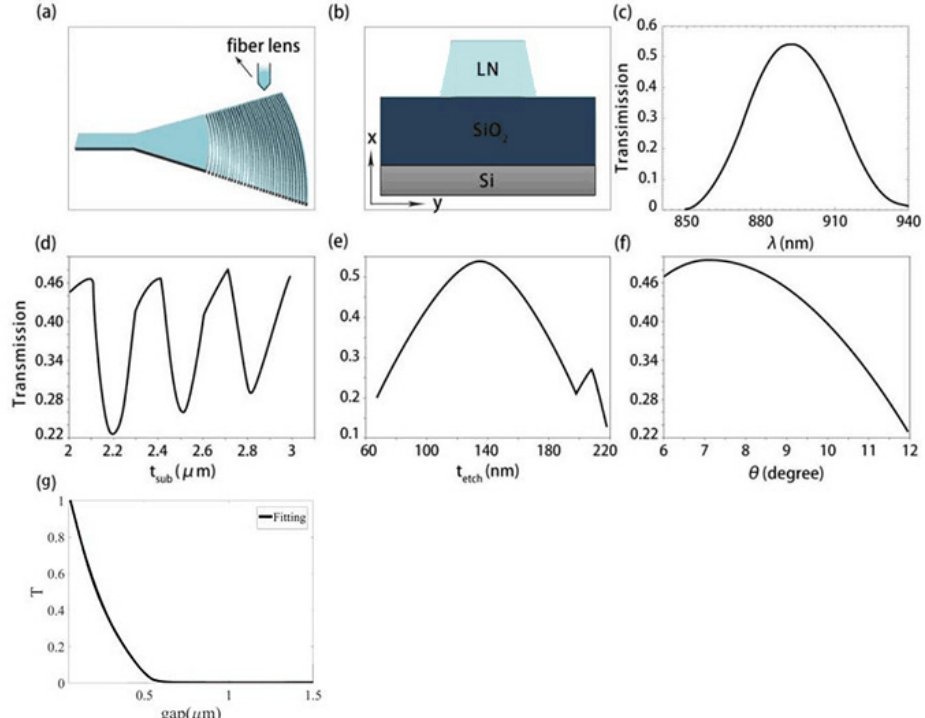
Figure 4. ( a ) Structure of the fan-out grating and fiber lens; ( b ) cross-section view of the multilayer structure of the grating simulated grating transmission versus (the y axis is perpendicular to the xz plane) ( c ) wavelength, ( d ) thickness of the SiO 2 substrate, ( e ) etching depth, and ( f ) relative angle of the coupling fiber with respect to the vertical direction; ( g ) the curve describes the variation of the grating transmittance with the